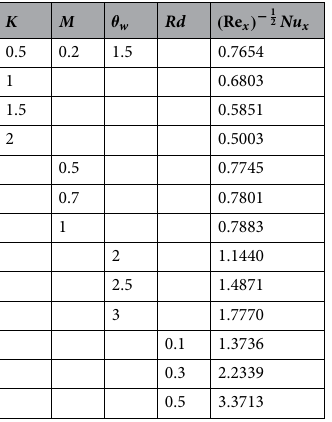
1 2 Nu x for various variations of K , M , θ w , Rd when Pr = 7 and B 1 = B 2 = 0.5. Table 3. Computations of ( Re x )